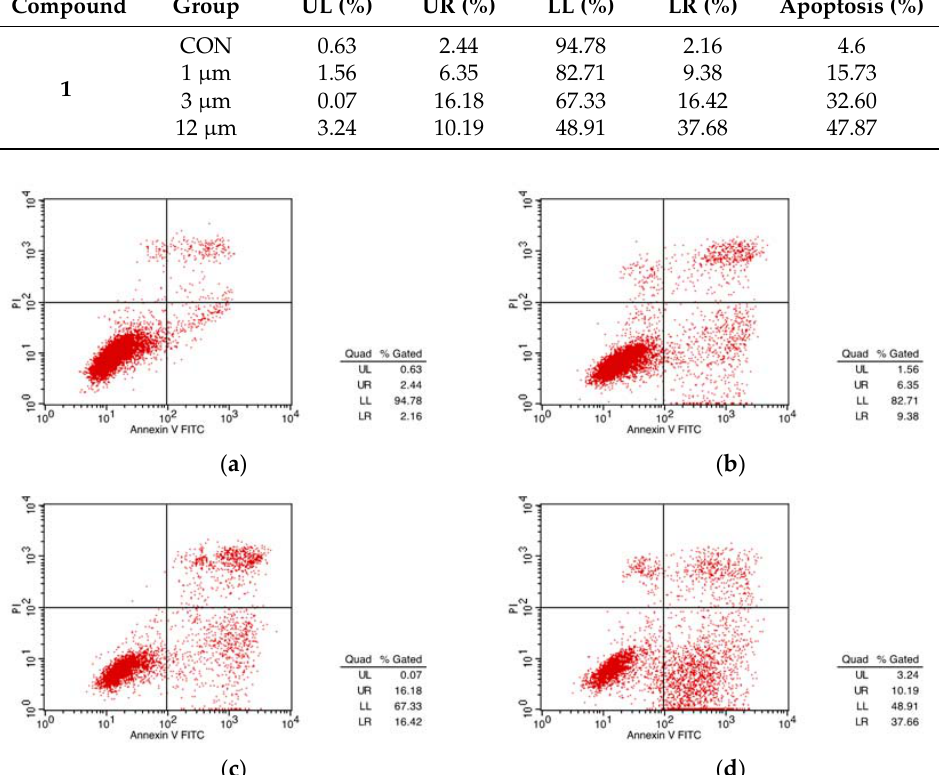
Table 3. Effect of compound 1 on the apoptosis rate of HepG2 cells.